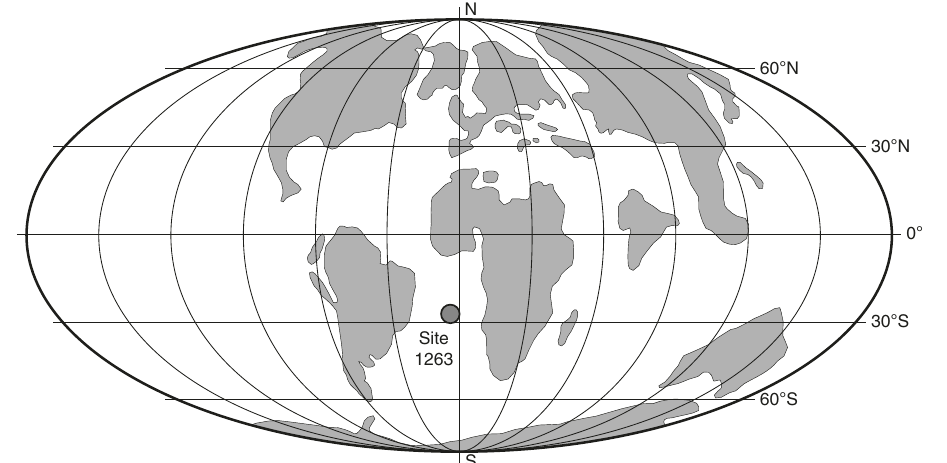
Fig. 1 Location of ODP Site 1263 during the Late Palaeocene. The core (current latitude: 28°32 ′ S; longitude: 02°47 ′ E) is on Walvis Ridge, southeastern Atlantic Ocean. Plate tectonic reconstruction is from the Ocean Drilling Stratigraphic Network (ODSN) database at